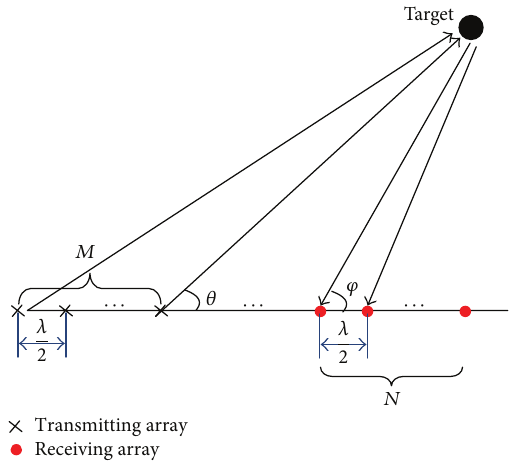
Figure 1: The configuration of bistatic MIMO